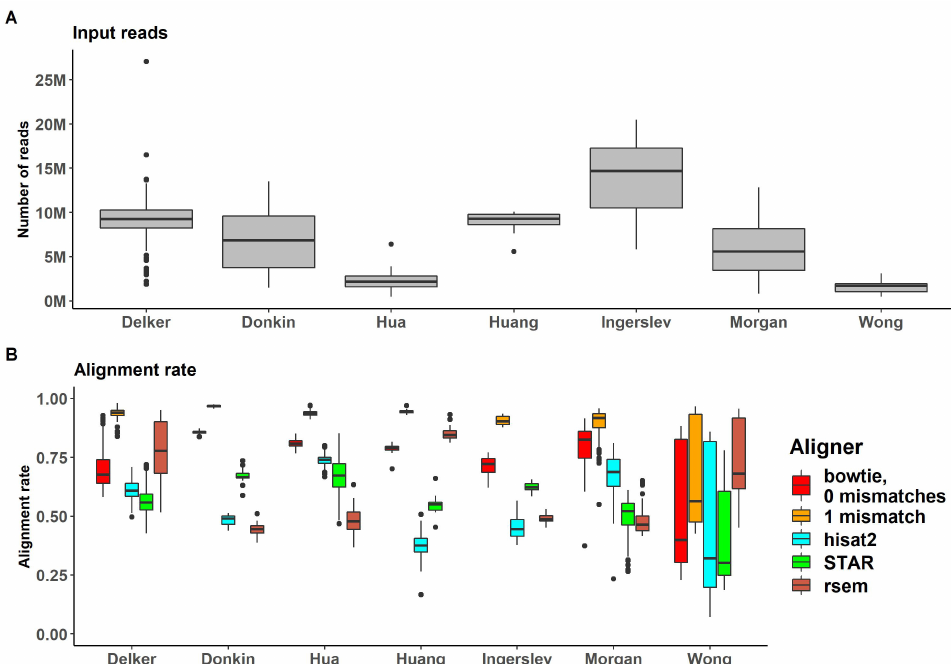
Figure 3. ( A ) Percent of reads passing the genome alignment (for bowtie, hist2 and STAR genome aligners) or prebuilt transcriptome (for RSEM) ( B ) Number of reads passing the genome align- ment (for bowtie, hist2 and STAR genome aligners) or prebuilt transcriptome (for RSEM) across all datasets